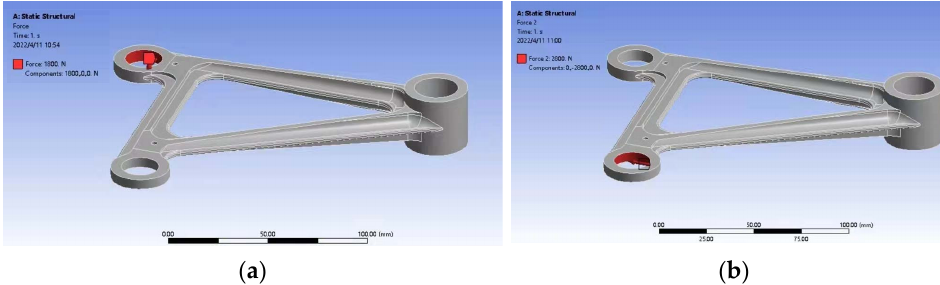
Figure 14. The rocker arm is loaded by force: ( a ) Load the force along the positive X axis; ( b ) Load the force in the negative Y direction.